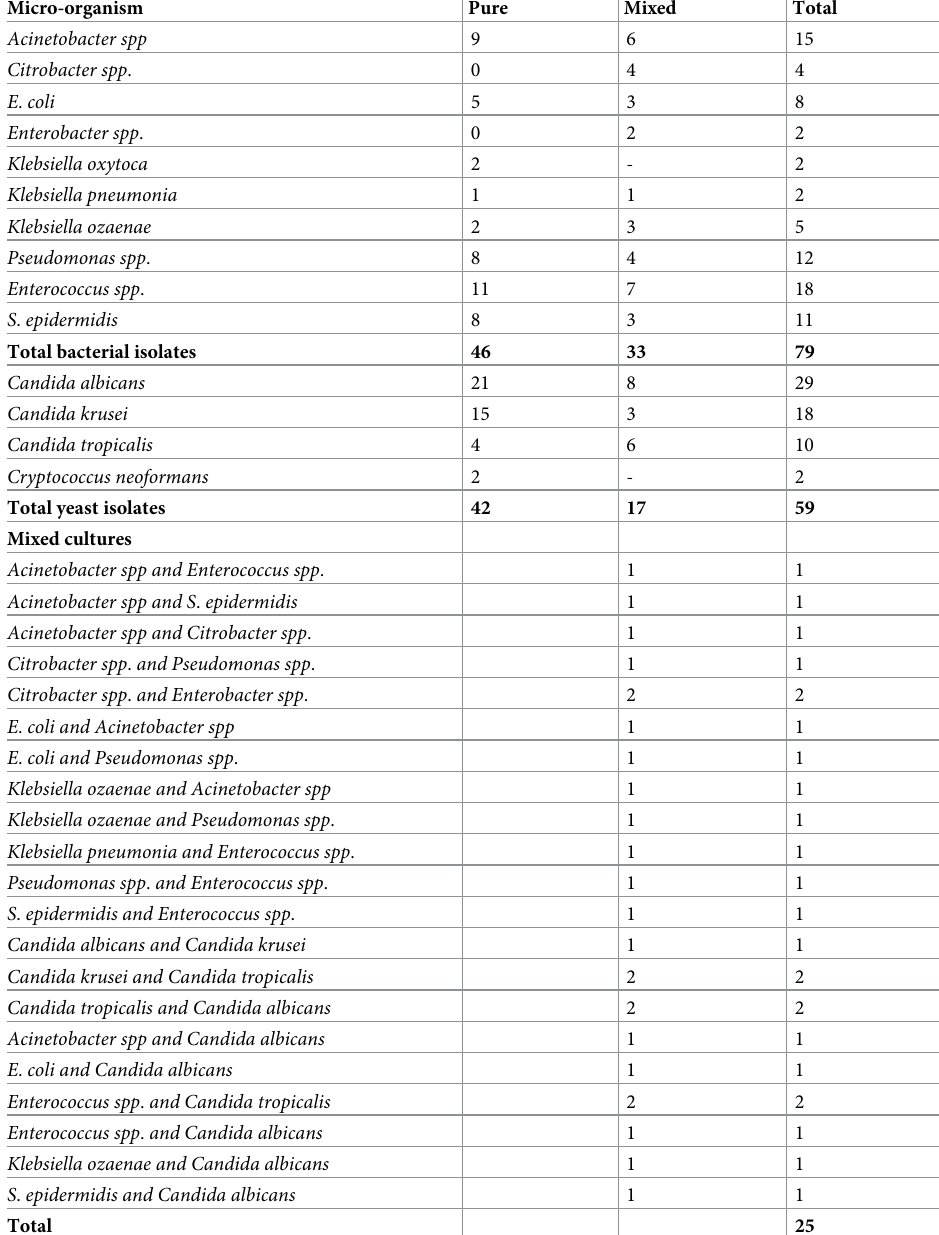
nitrofurantoin with a resistance rate extending from 0–60%. Gram-positive bacteria were rela- tively less resistant compared to Gram-negative bacteria (Table 5). The prevalence rate of MDR in Gram-positive and Gram-negative bacteria is shown in Table 6. Out of 79 bacterial pathogens, 52(65.8%) were MDR. Of this 37(71.0%) were Gram- negative bacteria whereas 15(28.2%%) were Gram-positive bacteria. Out of 15 isolates of Aci- netobacter species, 13 (86.7%) were MDR while all isolates of Klebsiella species (100%) and E .